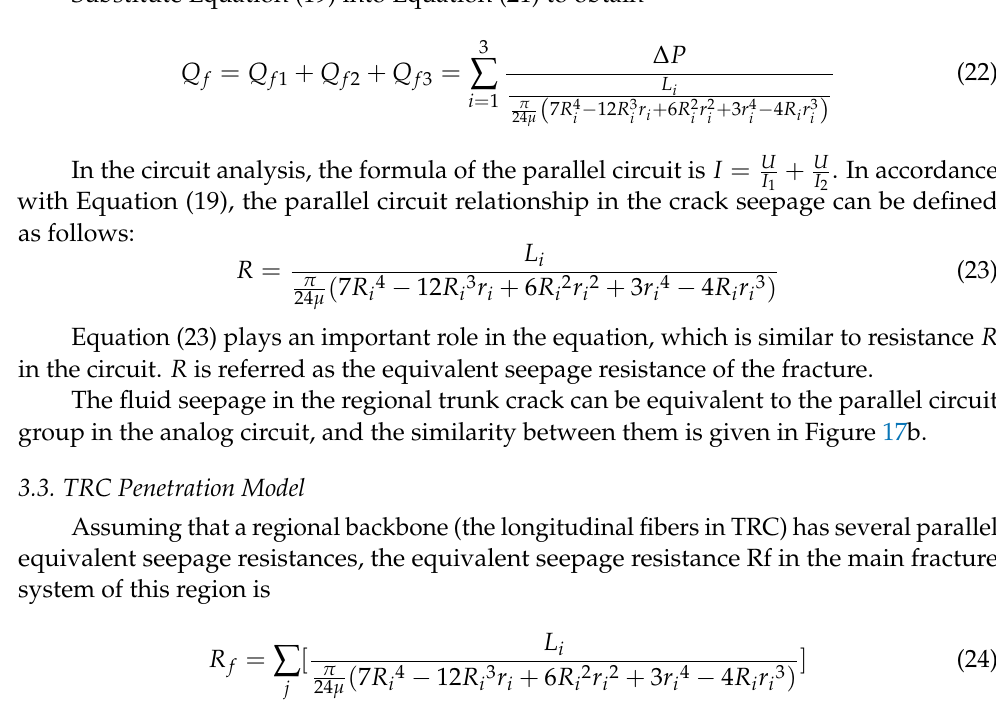
Figure 17. Schematic diagram of hydropower similarity principle; ( a ) parallel cracks; ( b ) analog circuit.